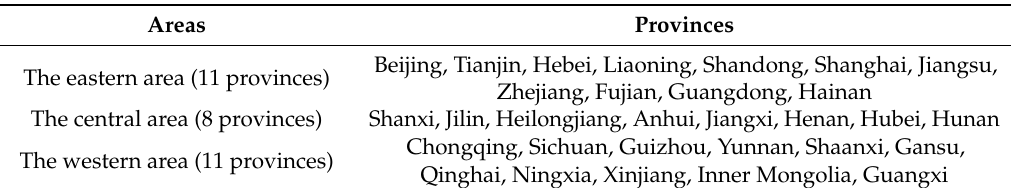
Table 5. Area division in China.